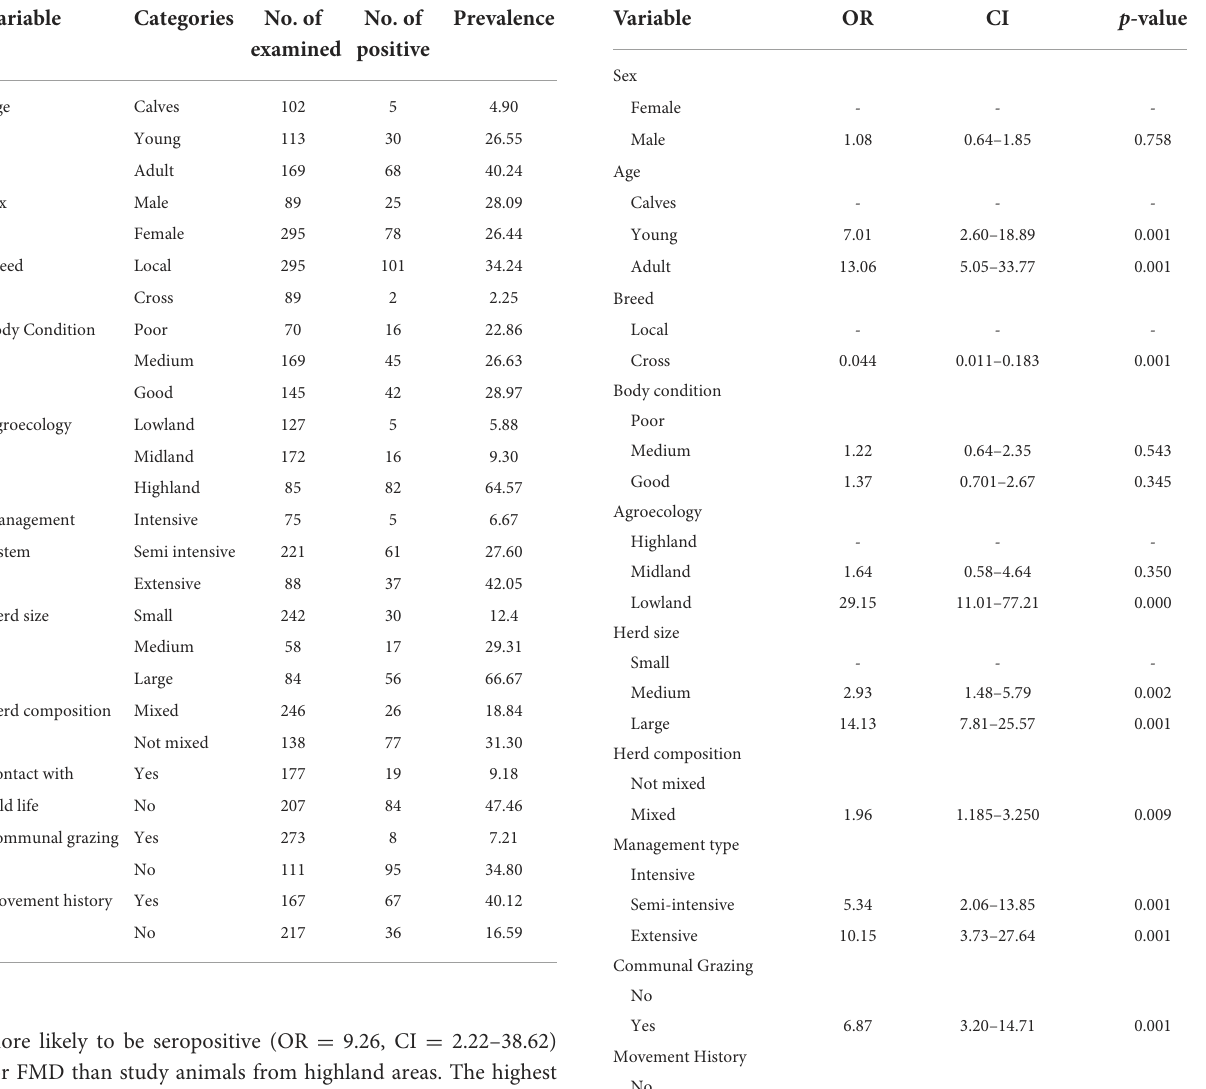
TABLE 2 Summary of the risk factors of FMD. TABLE 3 Univariable logistic regression results of risk factor